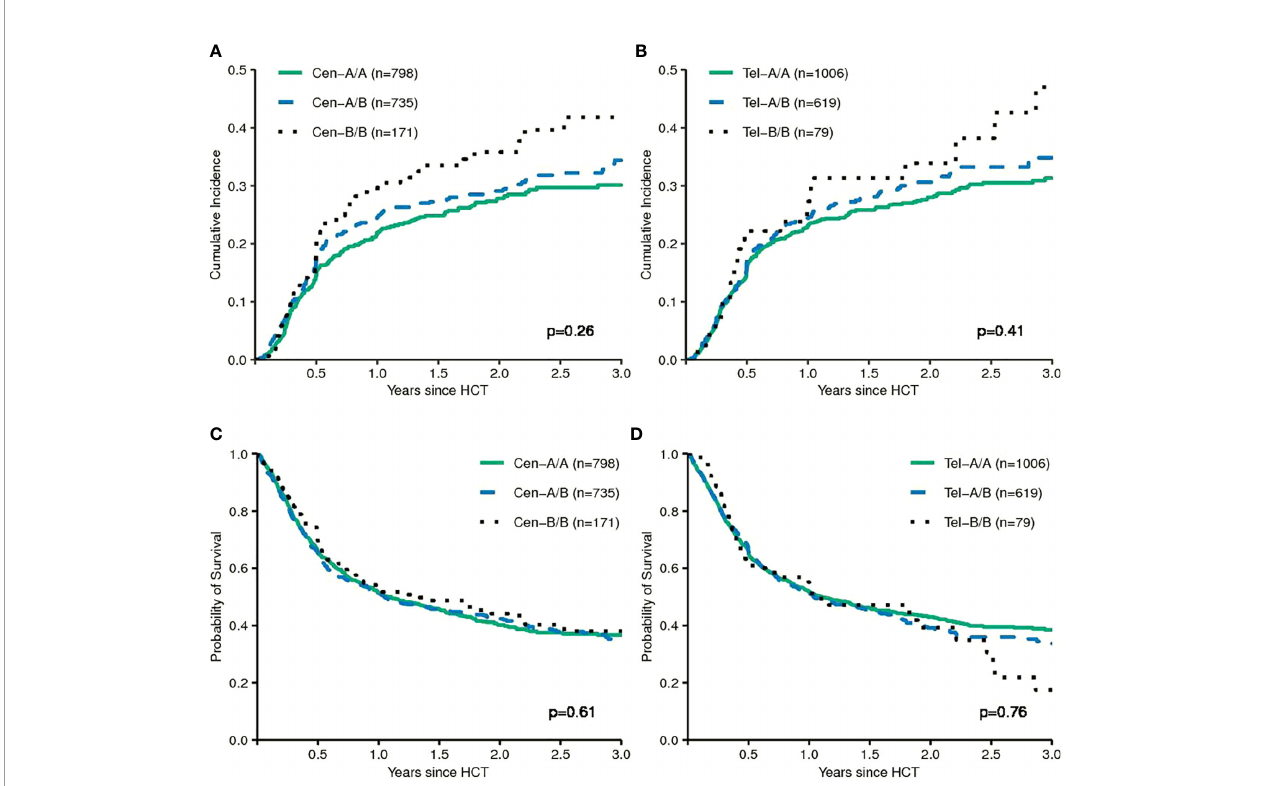
FIGURE 3 | The upper panels show the cumulative incidences of relapse of patients grouped according to centromeric KIR motifs (A) and grouped according to telomeric KIR motifs (B) . The lower panels show event-free survival of patients grouped according to centromeric KIR motifs (C) and grouped according to telomeric KIR motifs (D) . The p-values have been calculated by the Gray Test (Cumulative Incidence of Relapse) and the log-rank test (Event-free